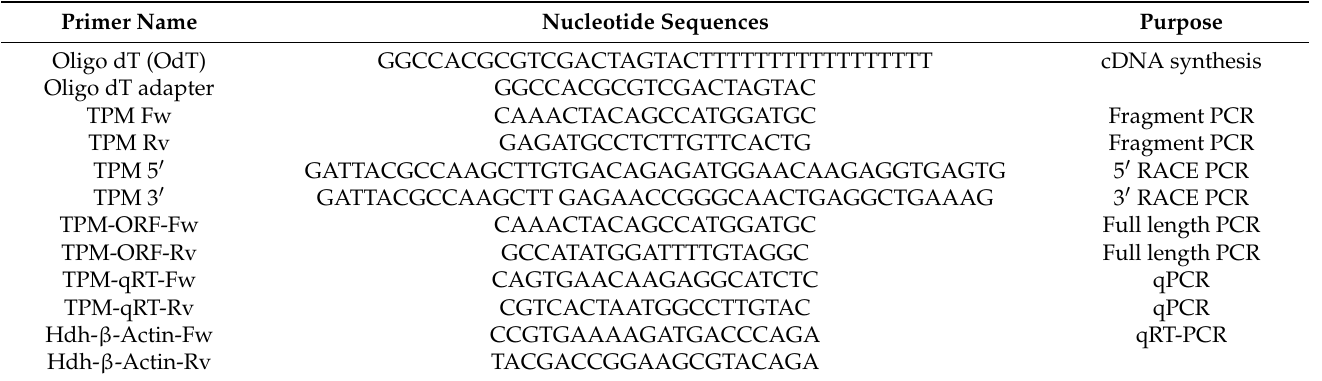
Table 1. List of different primers used for cDNA synthesis, cloning, and expression analysis in this